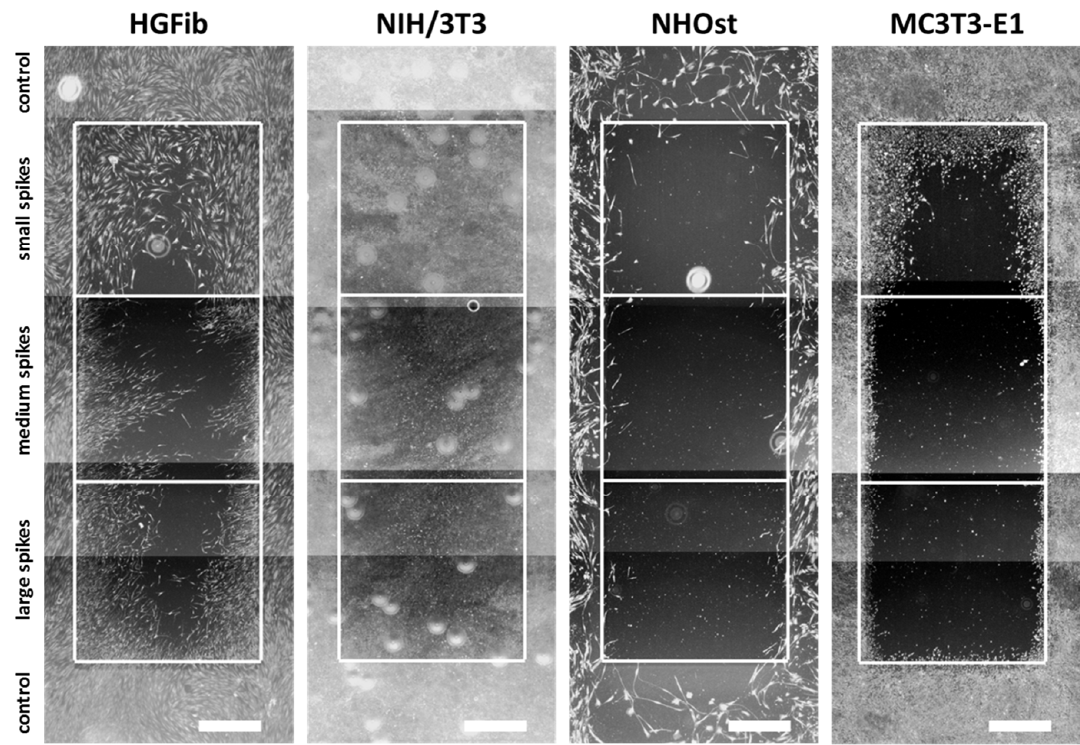
Figure 5. Cellular migration on spike topographies after 14 d. HGFib, NIH/3T3, NHOst, and MC3T3- Figure5. Cellularmigrationonspiketopographiesafter14days. HGFib,NIH / 3T3,NHOst,andMC3T3-E1 E1 were cultivated for 14 d and stained with Calcein-AM. Scale = 1 mm. were cultivated for 14 days and stained with Calcein-AM. Scale = 1